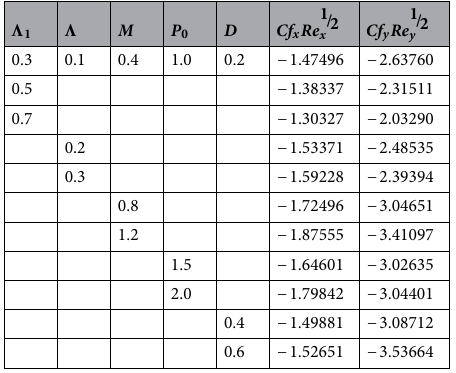
Table 1. The arithmetical results for skin friction along x and y direction.